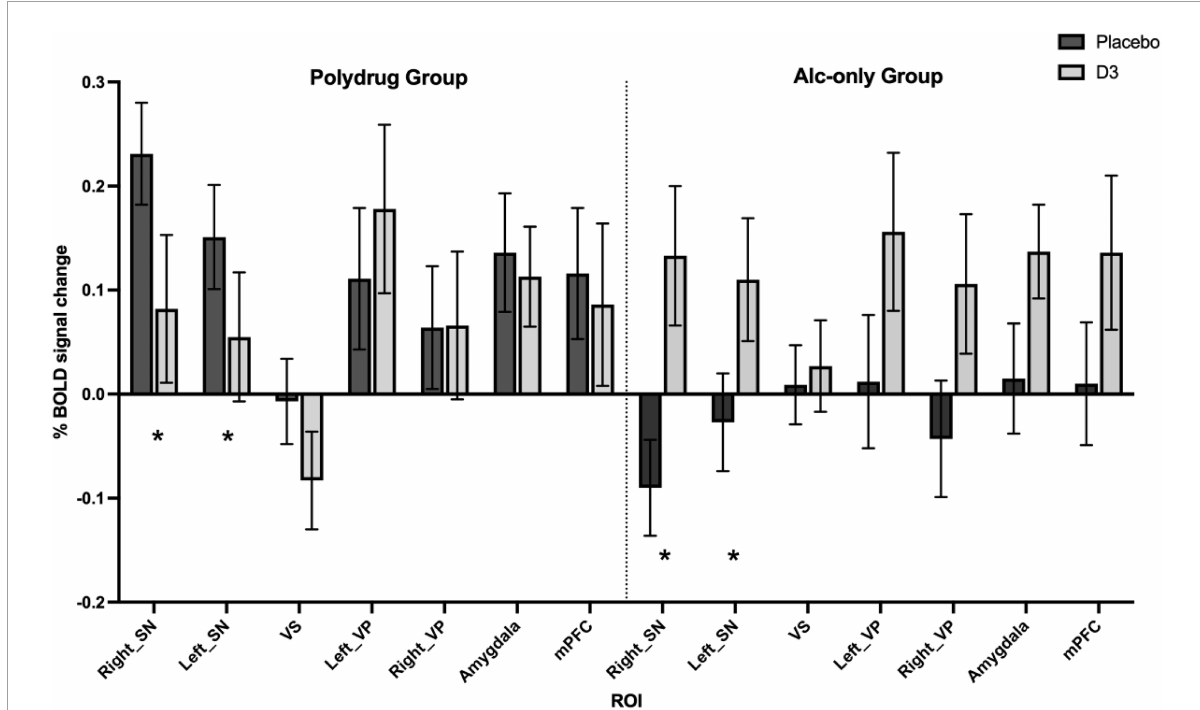
FIGURE4 Differential effect of D3 antagonism by ROI in AO vs. PD groups. A significant subgroup by drug by ROI interaction was observed in multivariate analysis [Pillai’s trace; F ( 6 , 26 ) = 2.659, p = 0.038], with post hoc analysis revealing significant effects in right and left substantia nigra (SN), see Supplementary Table 5 . *Denotes the regions in which significant interactions occurred, primarily driven by a divergent effect of drug in AO compared with PD subgroups. Data are % BOLD signal change during the aversive > neutral contrast following administration of placebo and GSK598809 across PD ( n = 17) and AO ( n = 19) groups, controlling for age and center. Values are estimated marginal means ( ± SEM, with covariates appearing in the model evaluated at the following values: Centre1 = 0.11, Centre2 = 0.31, Age =